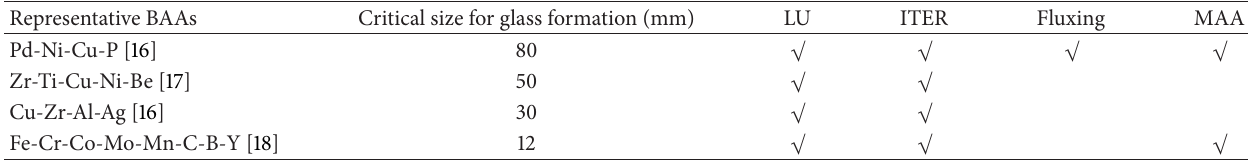
Table 1: The strategies for producing centimeter-scale amorphous